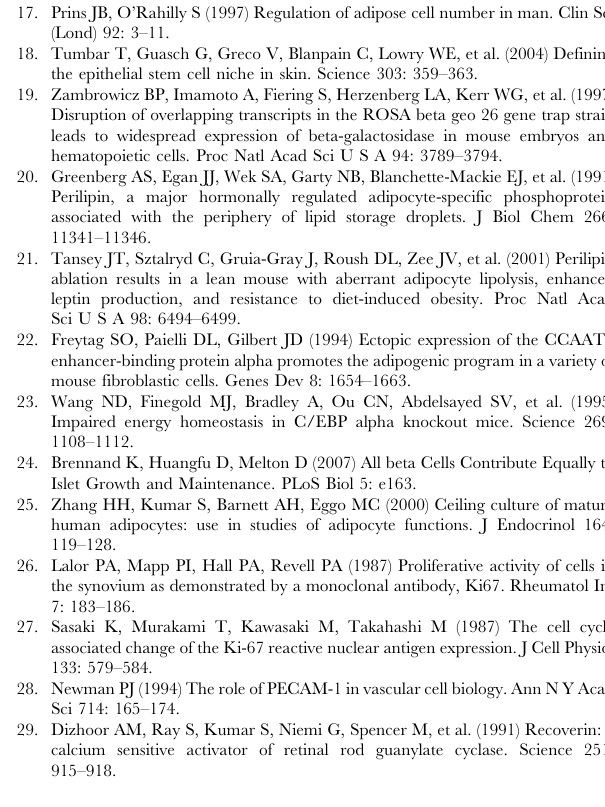
Figure S1 Confocal microscopy images demonstrating little overlap between CEBP a and CD31 or MAC1. A. The vascular endothelial marker CD31 (green) overlaps with DAPI (blue) but not with the adipocyte maker perilipin (red) in adipose tissue. Scale bars 100 m m. B,C. The macrophage marker Mac1 (green) overlaps with DAPI (blue) but not the adipocyte maker perilipin (red) ( B ) or those cells strongly expressing C/EBP a (red) ( C ) in adipose tissue. Scale bars 100 m m. (TIF) Table S1 Ki67 and BrdU Counts in Adipose Tissue.